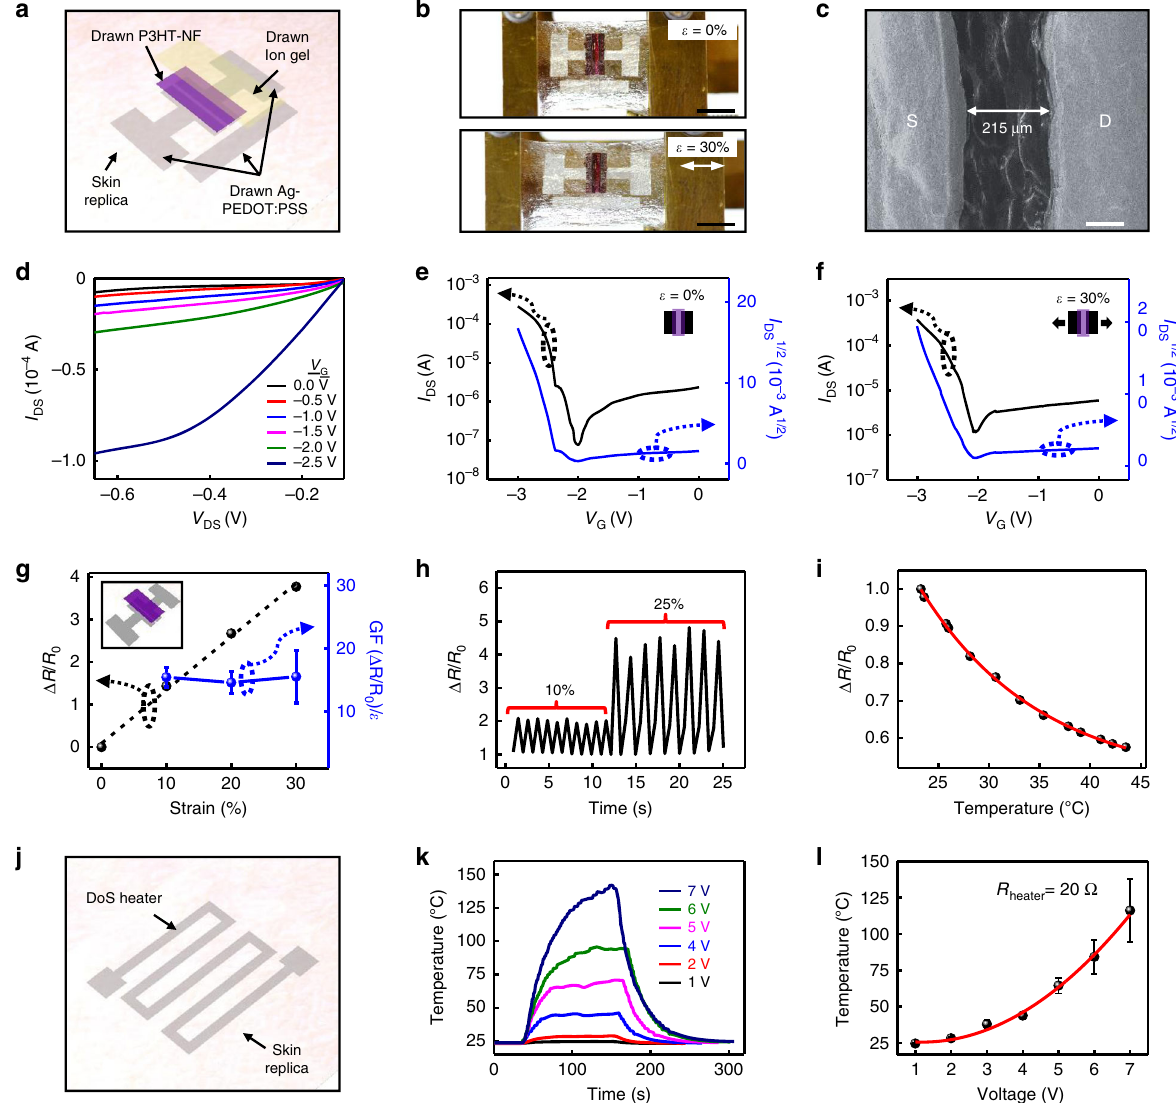
Fig. 2 DoS electronic devices and sensors on skin replica. a Schematic of the DoS transistor based on the Ag-PEDOT:PSS ink as the conductor, P3HT-NF ink as the semiconductor, and ionic gel ink as the dielectric. b DoS transistor on skin replica under no strain (top) and 30% strain (bottom, scale bars 5 mm). c SEM image of the drawn source (S) and drain (D) electrodes and the channel (scale bar 100 µ m). d I-V curve of DoS transistor without applied strain. e , f Transfer curves of DoS transistor without and 30% strain along the transistor channel length direction. g Electrical resistance of the DoS strain sensor under applied mechanical strain up to 30% and the corresponding gauge factors. Inset shows a schematic of the DoS strain sensor. The error bars represent the s.d. h Relative resistance change of the DoS strain sensor under cyclic stretching and releasing at 10% and 25% strain. i Relative resistance change of the DoS temperature sensor under different temperature conditions. j Schematic of the DoS heater based on the conductive ink. k Temperature pro fi les under different applied voltage on the DoS heater. l Calibration curve of the DoS heater. The error bars represent the